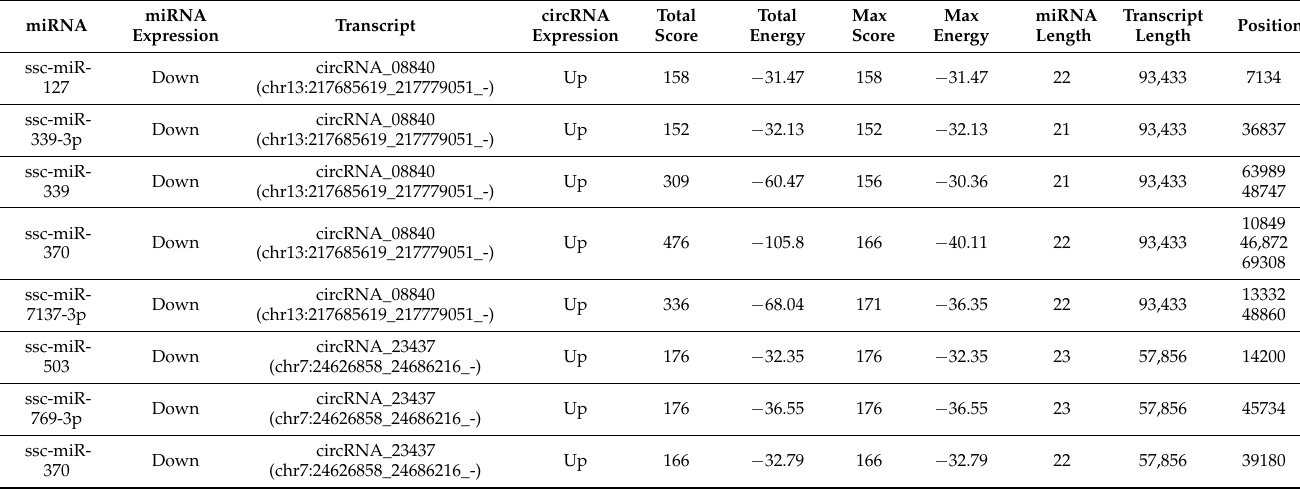
Table 2. circRNA-miRNA interactions and their expressions in the IMF tissues of Large White and Laiwu pigs. Note: the position represents the start site where the miRNA binds to the circRNA region. (Large White is a reference